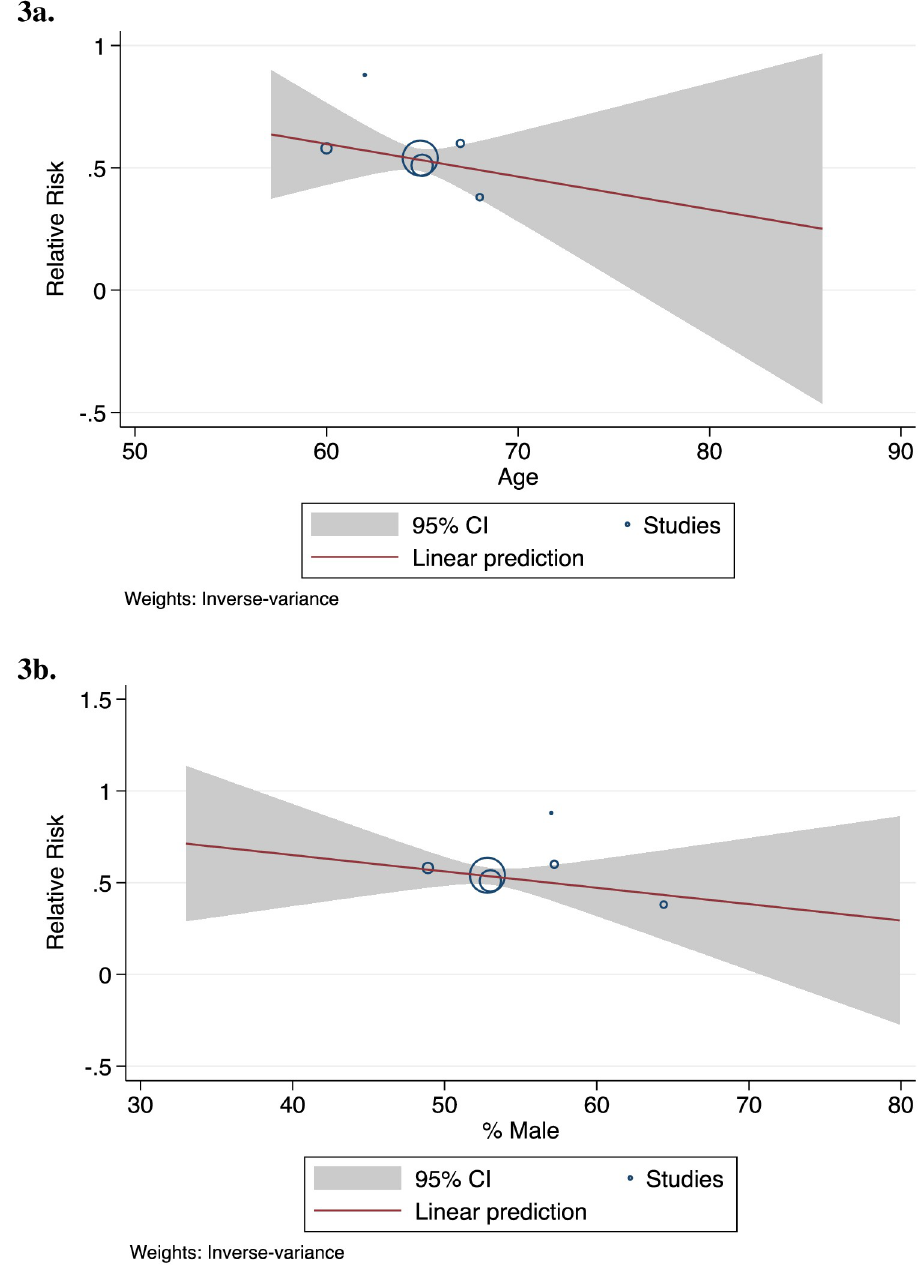
Fig 3. Statin use, after hospitalization. a By Age ( β = -0.01; p = 0.45) b By Percentage Male ( β = -0.01; p = 0.41).